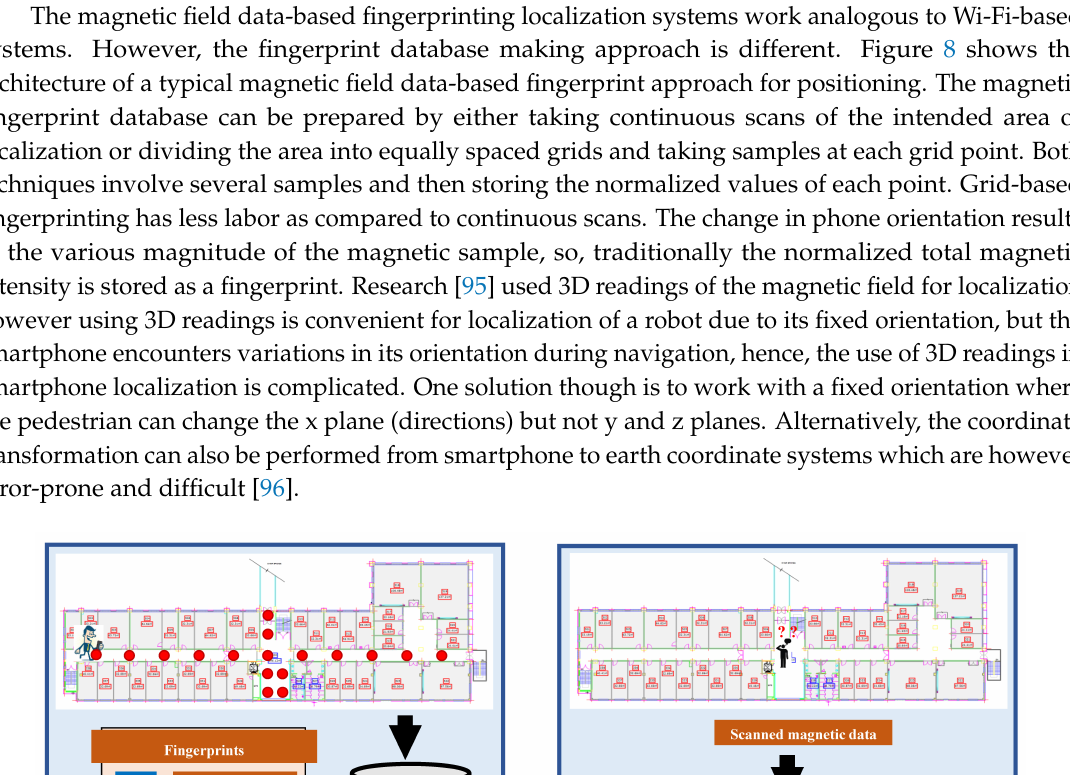
Figure 7. The components of magnetic field.